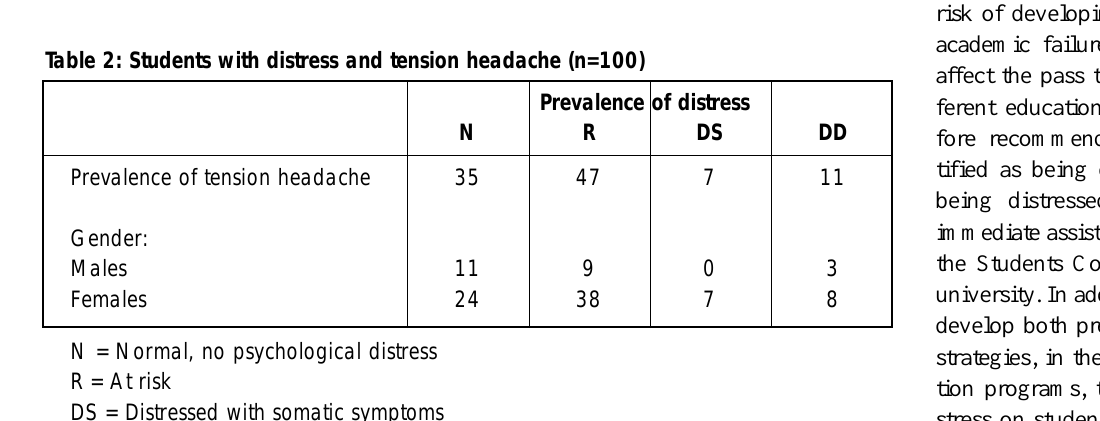
Table 2: Students with distress and tension headache (n=100)